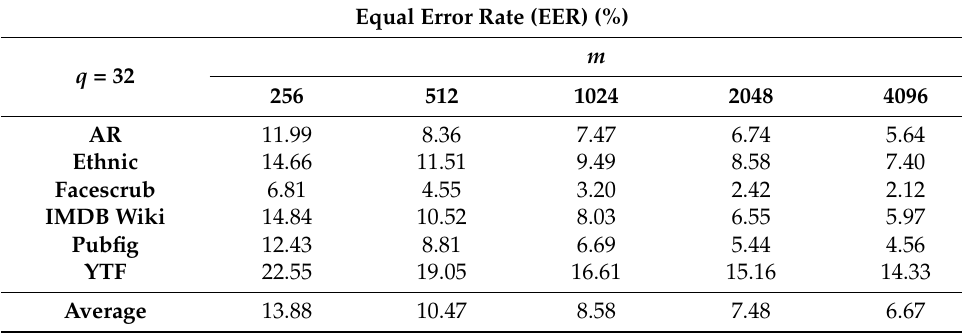
Table 2. Accuracy of the model for various values of m and q = 32.